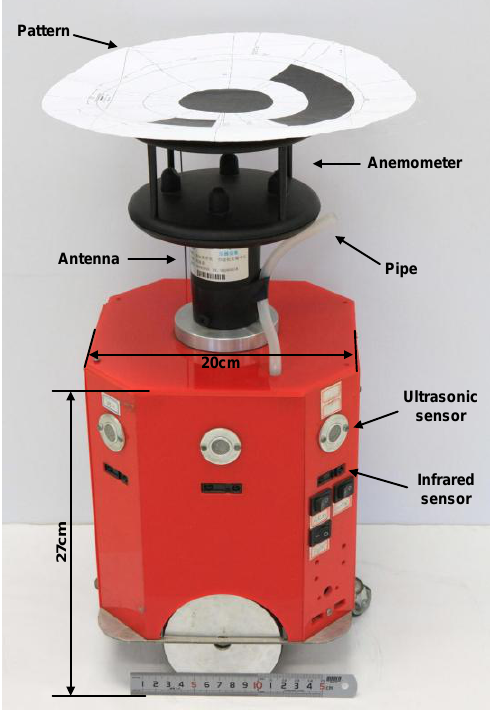
Figure 4. The small mobile robot MrCollie and its onboard